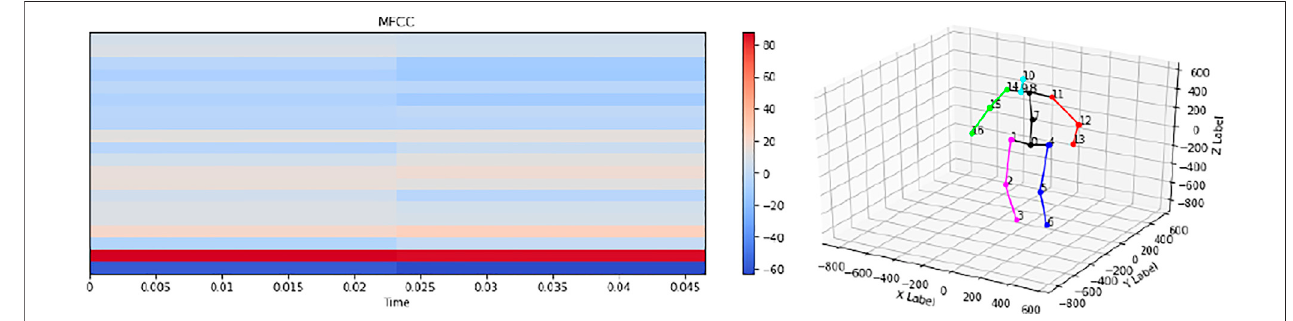
Frontiers in Robotics and AI |